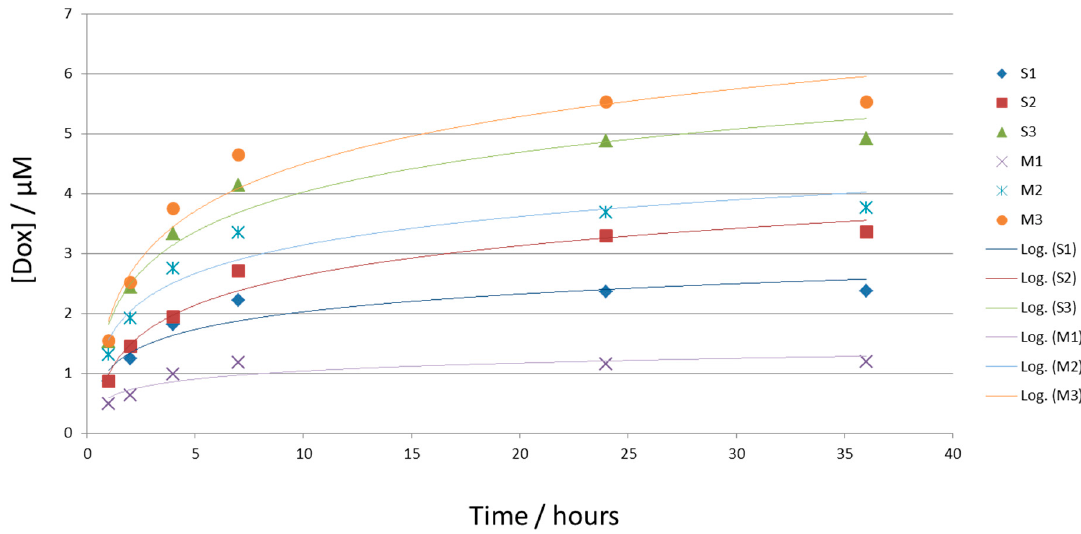
Figure 3. Uniform release characteristics of carrier systems tested. Equal amounts of Dox-loaded carriers were placed in a dialysis bag and dialyzed against a volume of 50 mL buffer under constant agitation (100 rpm). Optical densities of samples, corrected against dialysis medium were used to determine [Dox].